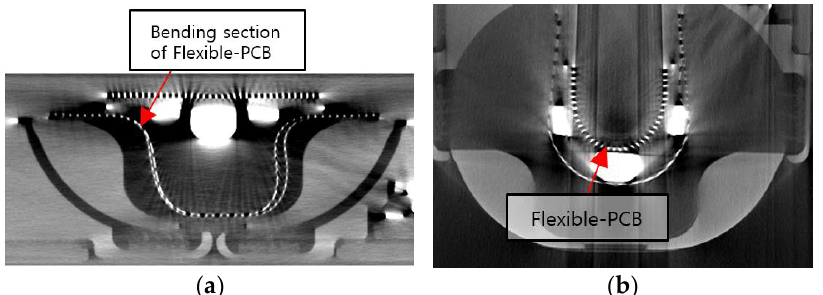
Figure 12. Bending test set-up for hinge structure of foldable mobile product. ( a ) Open condition CT image and ( b ) Closed condition CT image.